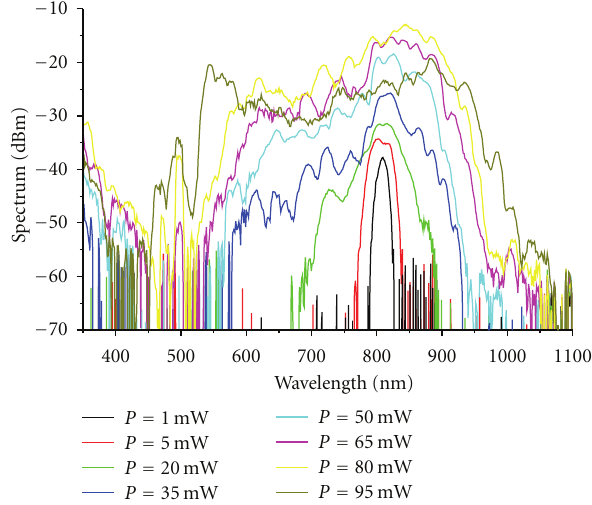
Figure 8: Experimental spectra for a 25-cm-long PCF versus wave- length at 805nm.